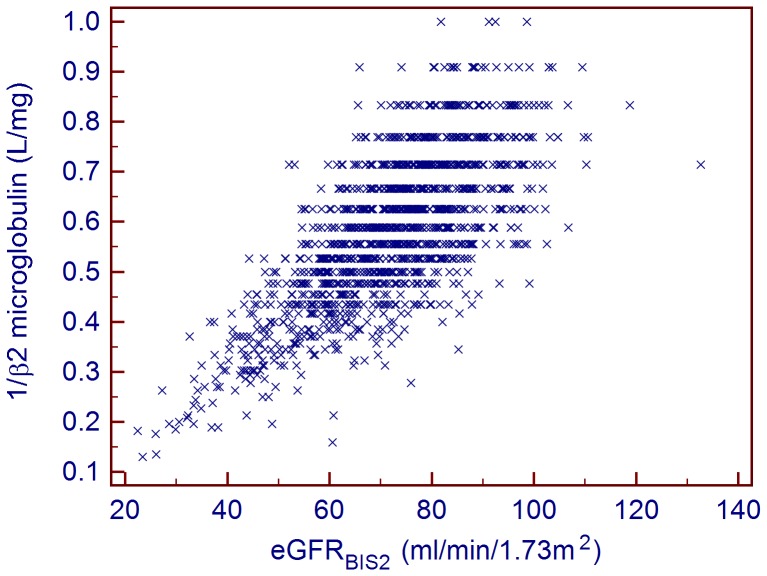
The relationship between β2-microglobulin and eGFRBIS2.